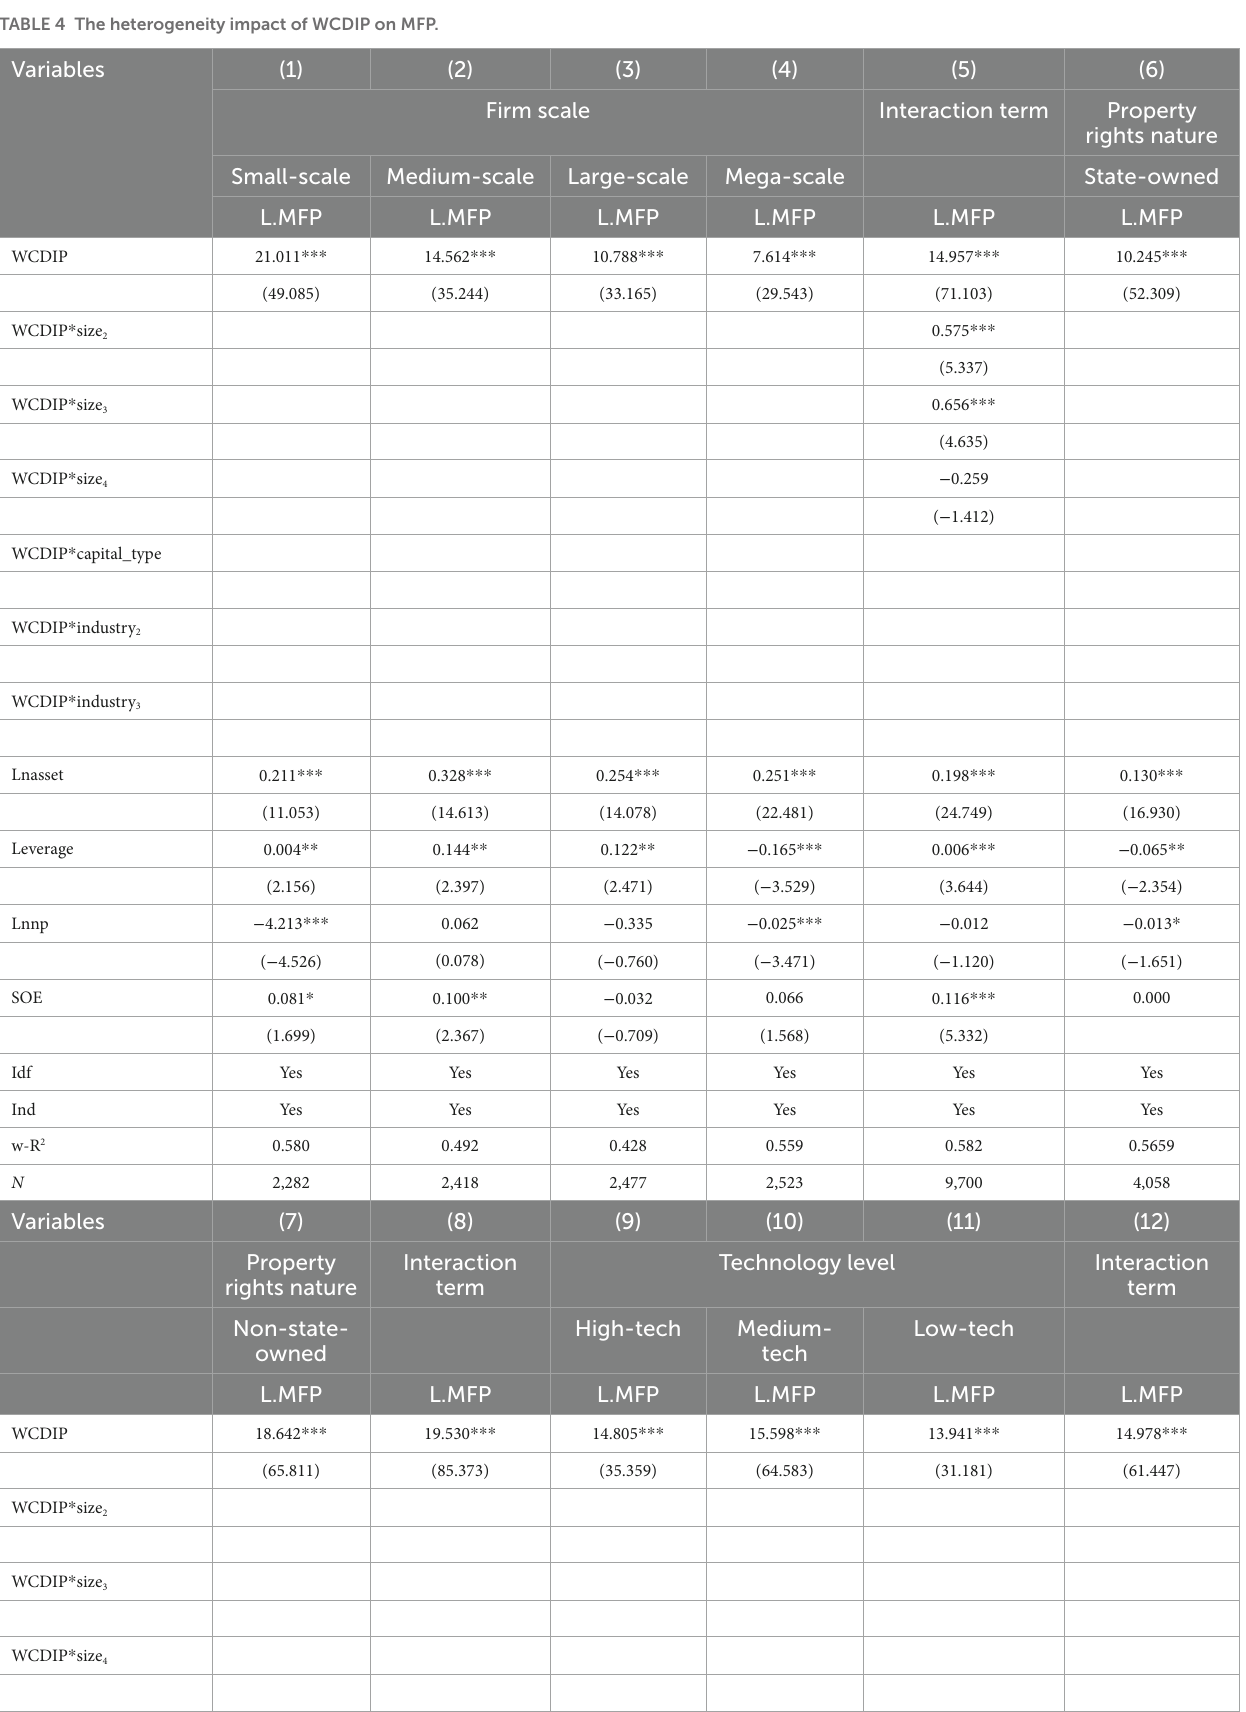
TABLE 4 The heterogeneity impact of WCDIP on MFP.